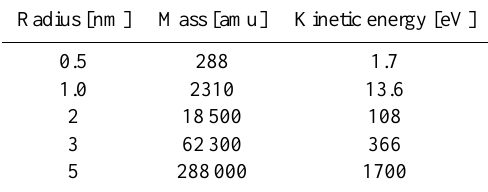
Table 2. Kinetic energy as a function of radius and mass for aerosol particles of ice. A velocity of 1km/s is